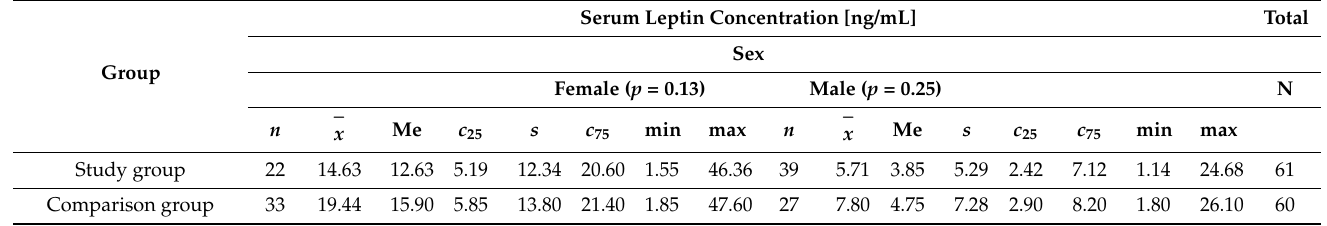
Table 4. Effect of leptin receptor expression on leptin concentration. Table 5. Comparison of leptin concentration in the study and comparison